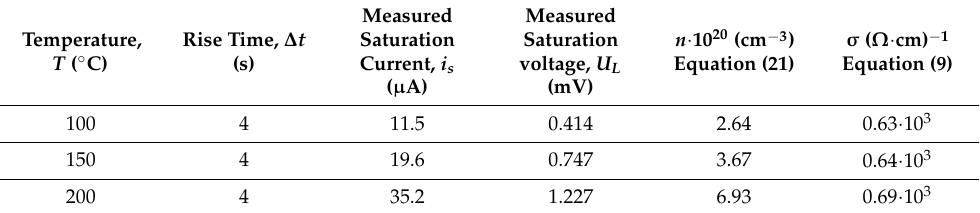
Table 3. Measured voltage and basic calculated parameters of the ITO film.